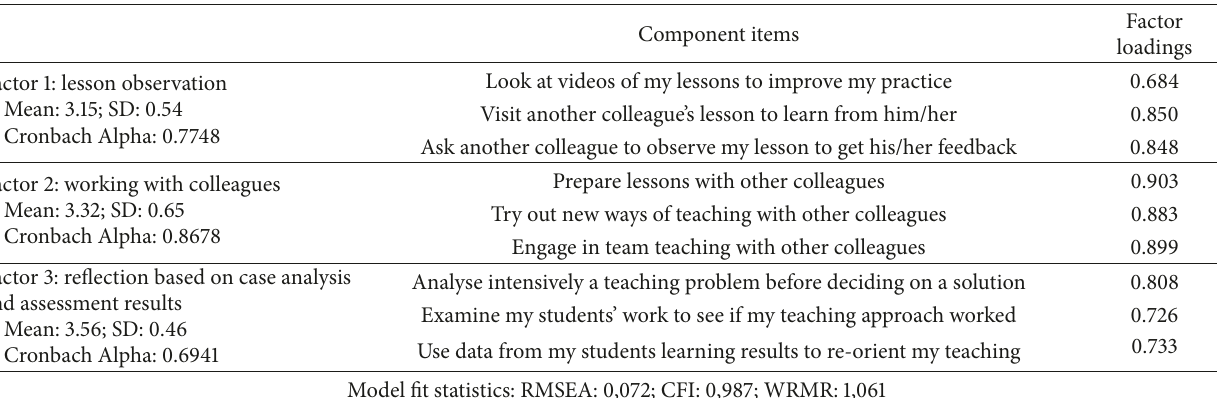
Table 2: Beliefs about professional development (degree of importance: 1 = not important; 4 = very important ) ∗ .